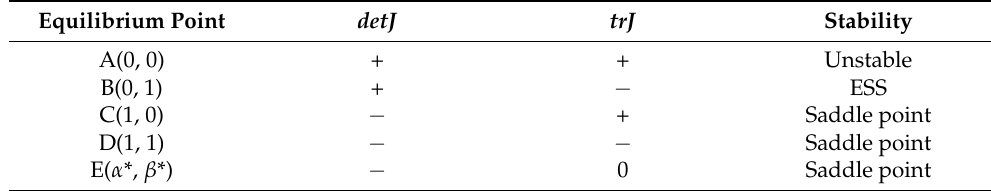
Table 11. Local stability analysis of scenario 2 between local government and the public.